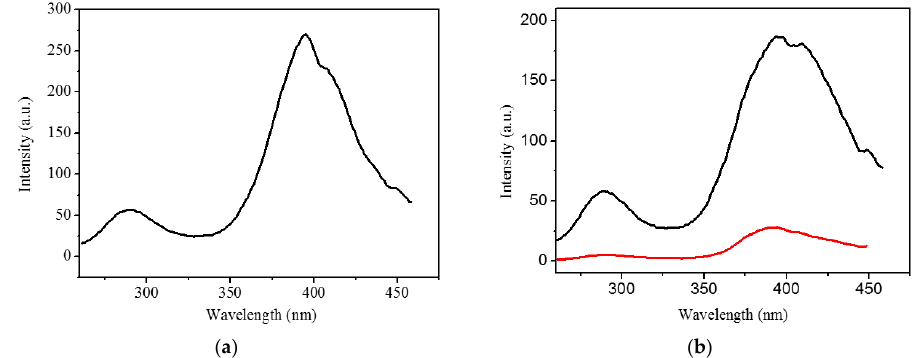
Figure 7. ( a ) Emission spectrum of 1 in a solid state at room temperature. ( b ) Emission spectra of 2 (black) and [BzQl]Br (red) in a solid state at room temperature.